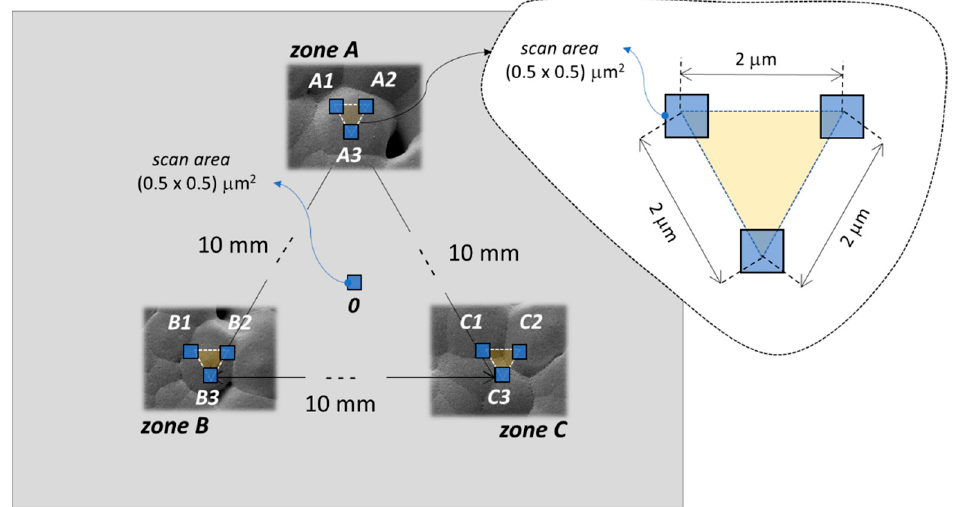
Figure 2. Sketch of the measurement points for the local piezoresponse of the sample through piezoresponse force microscopy (PFM).